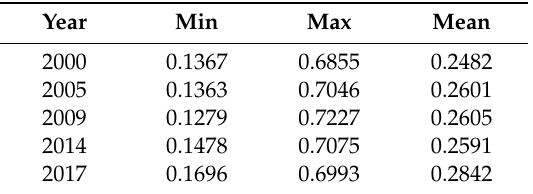
Table 2. Statistical information about the RSEI in China in 2000–2017.